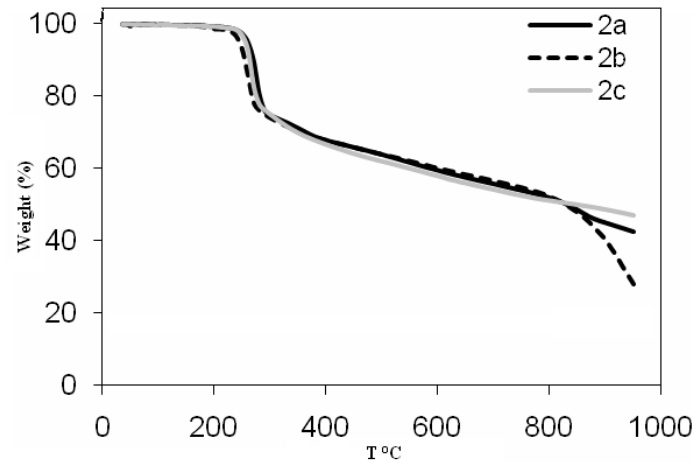
Figure 1. Thermogravimetric curves of ligands 2a – c .